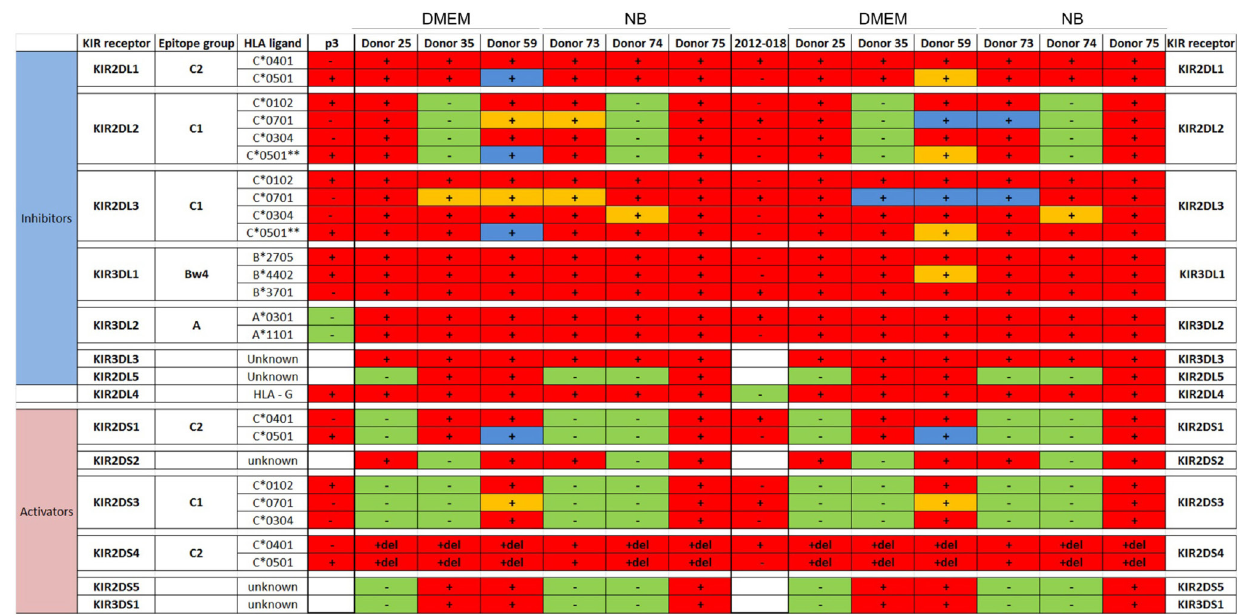
TaBle 2 | Killer immunoglobulin-like receptors (KIR)-human leukocyte antigen (HLA) genotype table for P3 and 2012-018 with healthy donors used for cytotoxicity assays.